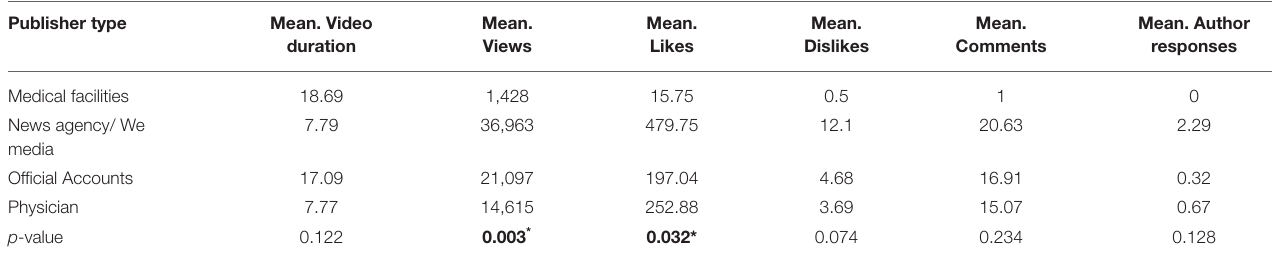
Mean. Video duration